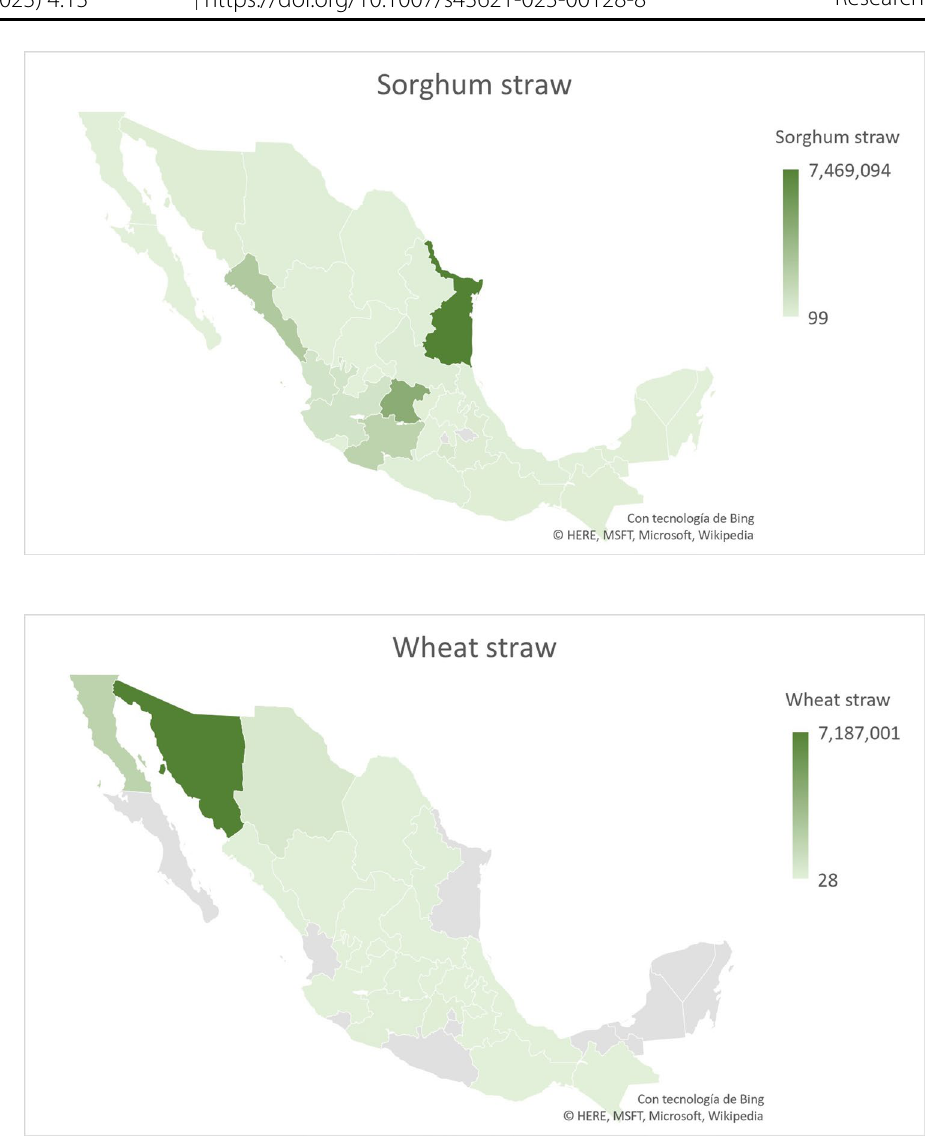
Fig. 4 Sorghum straw avail- ability (Mg/year) [Choropleth]